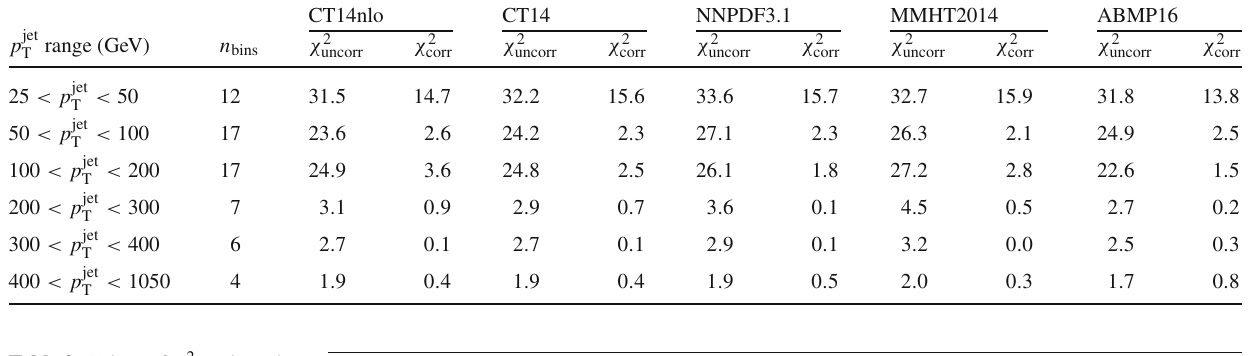
Table 2 Values of χ 2